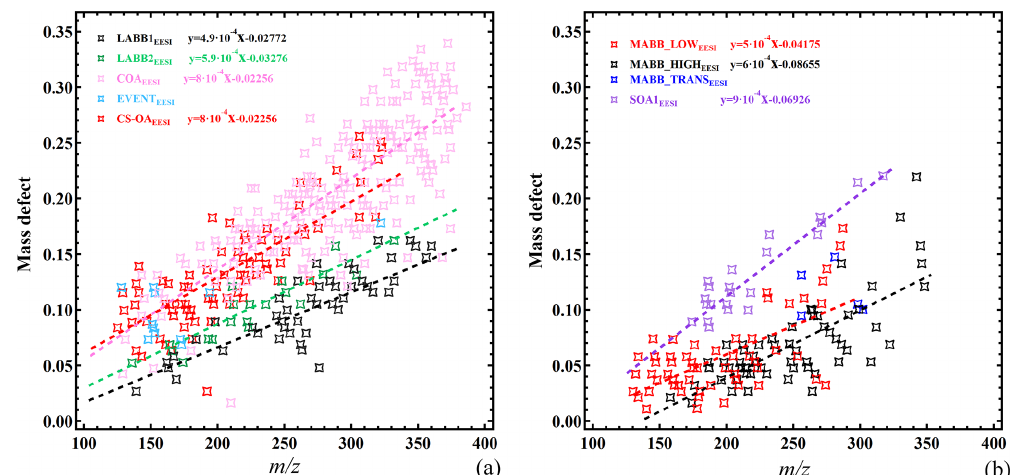
Figure 12. Mass defect filtering plot of factor-specific ions (identified from the cluster analysis) for selected EESI-TOF-MS POA (a) and SOA (b)